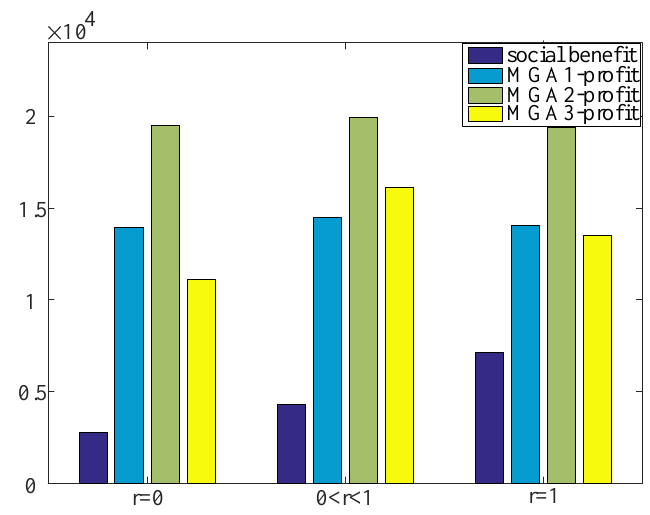
Figure 5. Operation costs of MGAs and social benefit.